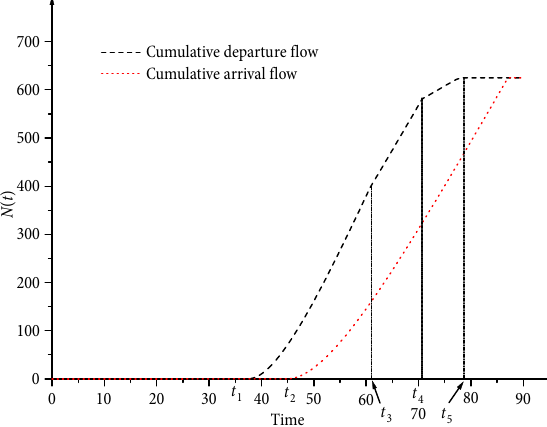
Fig. 4. Cumulative N -curves for the example in Subsection